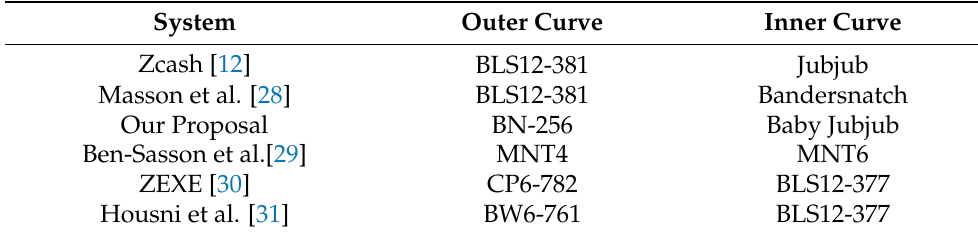
Table 1. Comparison with related